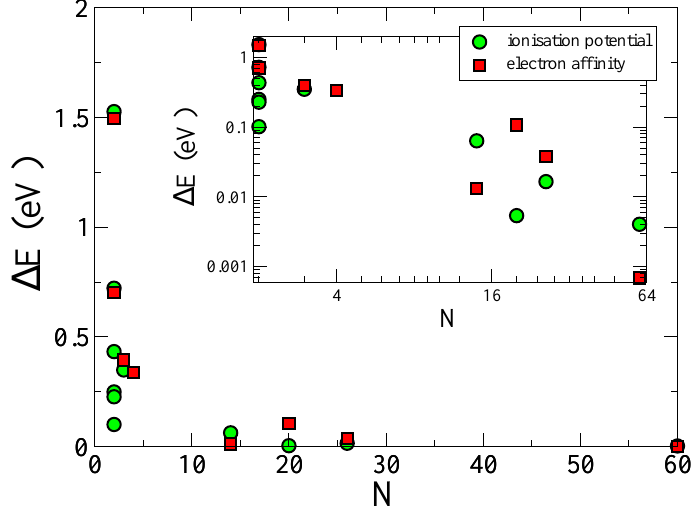
Figure 2. The ionization potentials and electron affinities of the molecules considered in Figure 1. We plot the difference in energy, ∆ E between the correct result (within the PBE approximation) and the results from approximating the ionization potential (electron affinity) by estimating the Hubbard U and relaxation energy from the O (1) method. It can be seen that the approximation improves dramatically as the number of atoms in the molecule, N , increases. The inset show the same data on a log-log scale, this suggests that the error in the approximation decreases as ∆ E ∼ N (cid:0) (cid:11) with α ∼ 1 . 5 – 2